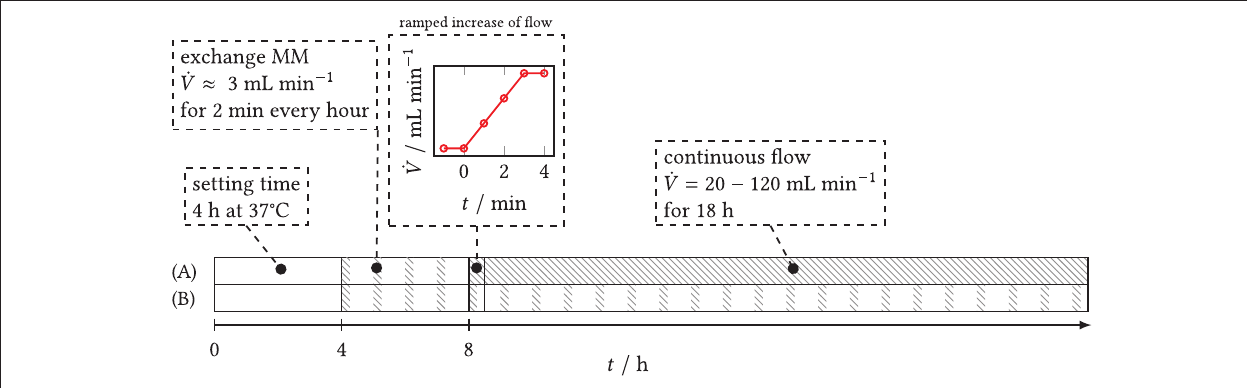
FIGURE 4 | Time schedule of flow experiments with step chamber. Gray shaded: active flow. (A) Experiments with target volume flow. After a settling time of 4h, the step chamber is connected to the pumping system and flowed through at intervals of 2min h − 1 each time over 4h to ensure sufficient oxygen saturation. A ramp is used to set the target flow rate of the main experiment and maintain it over 18h. (B) Blank sample: intermittent exchange of medium starting at t ≥ 4 h over the entire duration of the experiment.